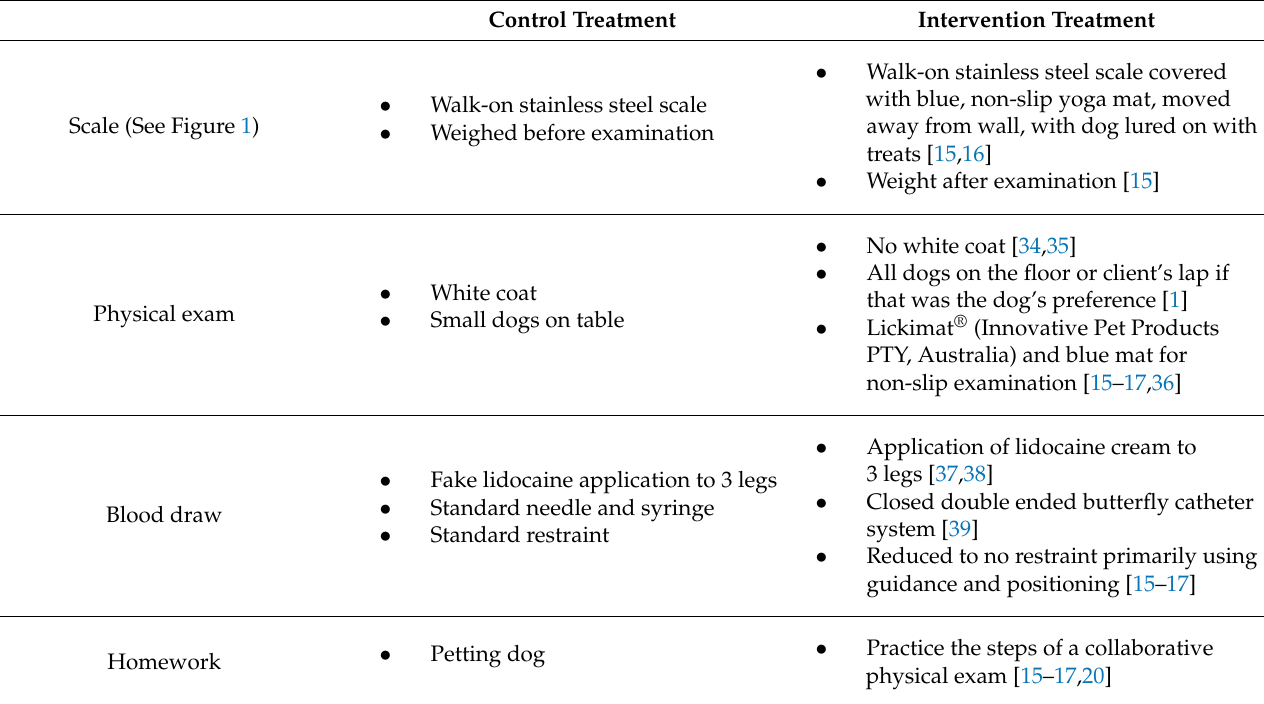
Table 2. Study protocol summaries for control and intervention